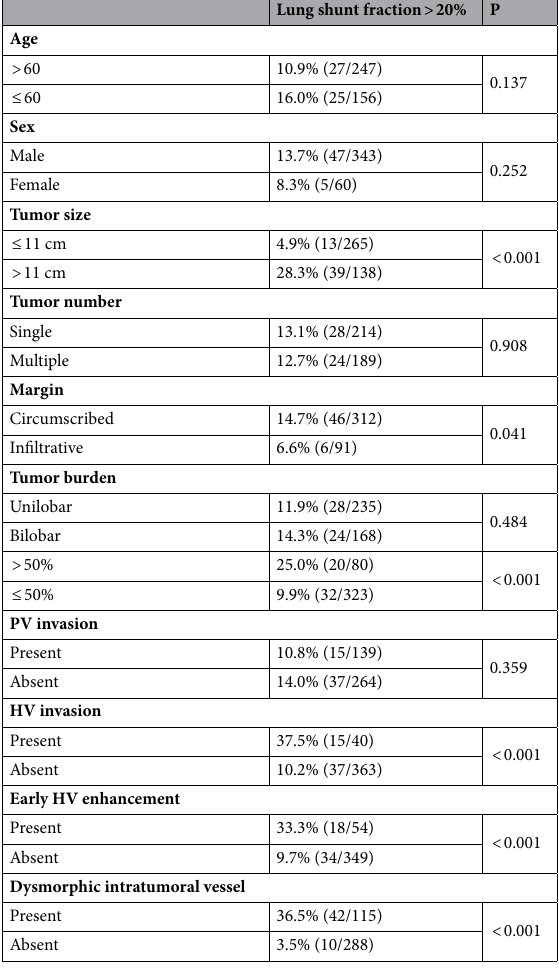
Table 1. Association between patients’ characteristics and lung shunt fraction. † P-values were calculated using the Pearson’s chi-square